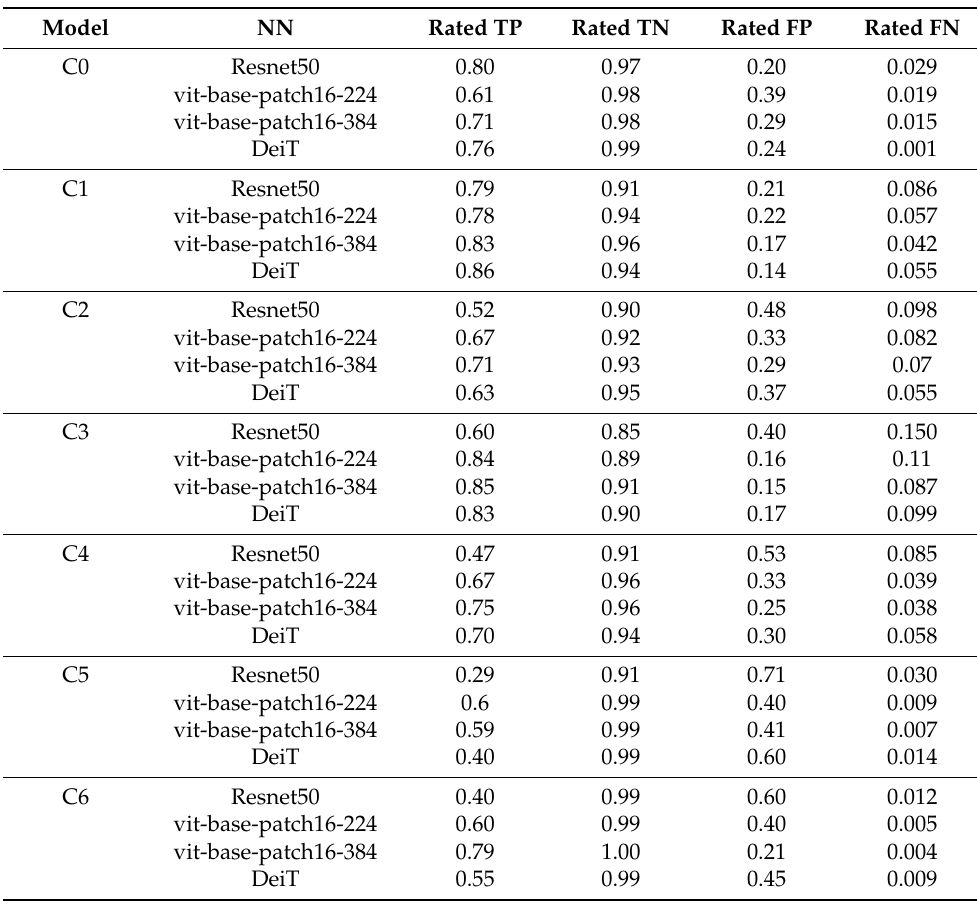
Table 3. The probabilities of classification for each CEAP